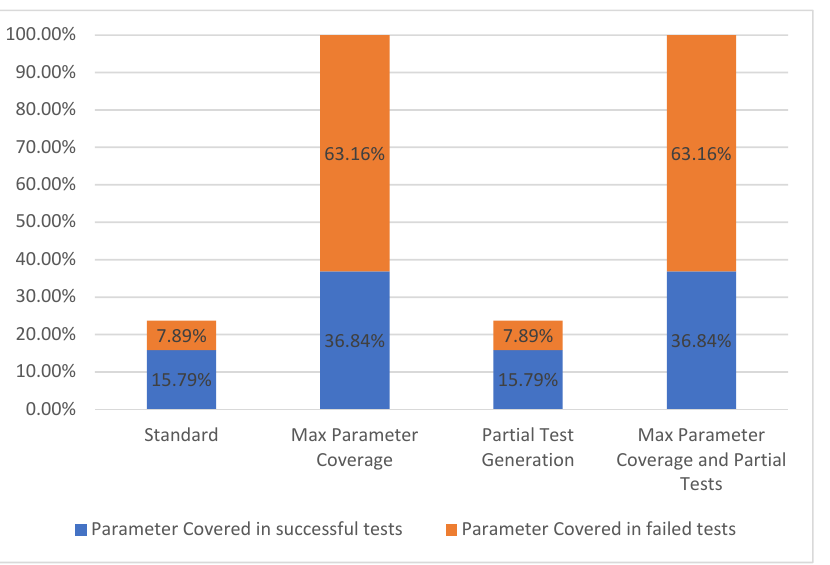
Figure 11. Parameter coverage.